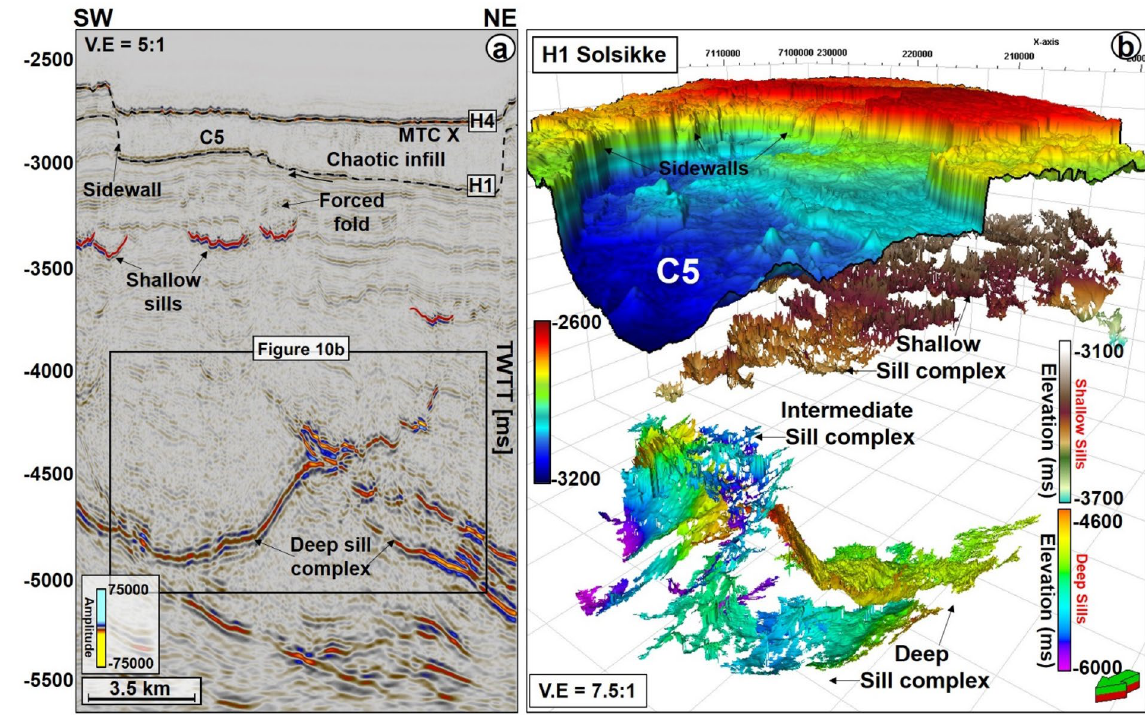
Figure 9. ( a ) SW-NE seismic profile showing crater C5 and underlying magmatic sills at a depth between 3300 ms and 5500 ms TWTT. Most of the shallow sills in the Solsikke area are interconnected saucer-shaped sills. N.B: An uninterpreted seismic profile is provided in the appendix. ( b ) 3D view showing the spatial relationship between C5 and underlying magmatic sills. In the study area, the interpreted magmatic sills are classified into shallow sills at depths < 4000 ms TWTT, intermediate sills occurring at a depth of 4000–5000 ms TWTT, and deeper sills occurring at depth > 5000 ms